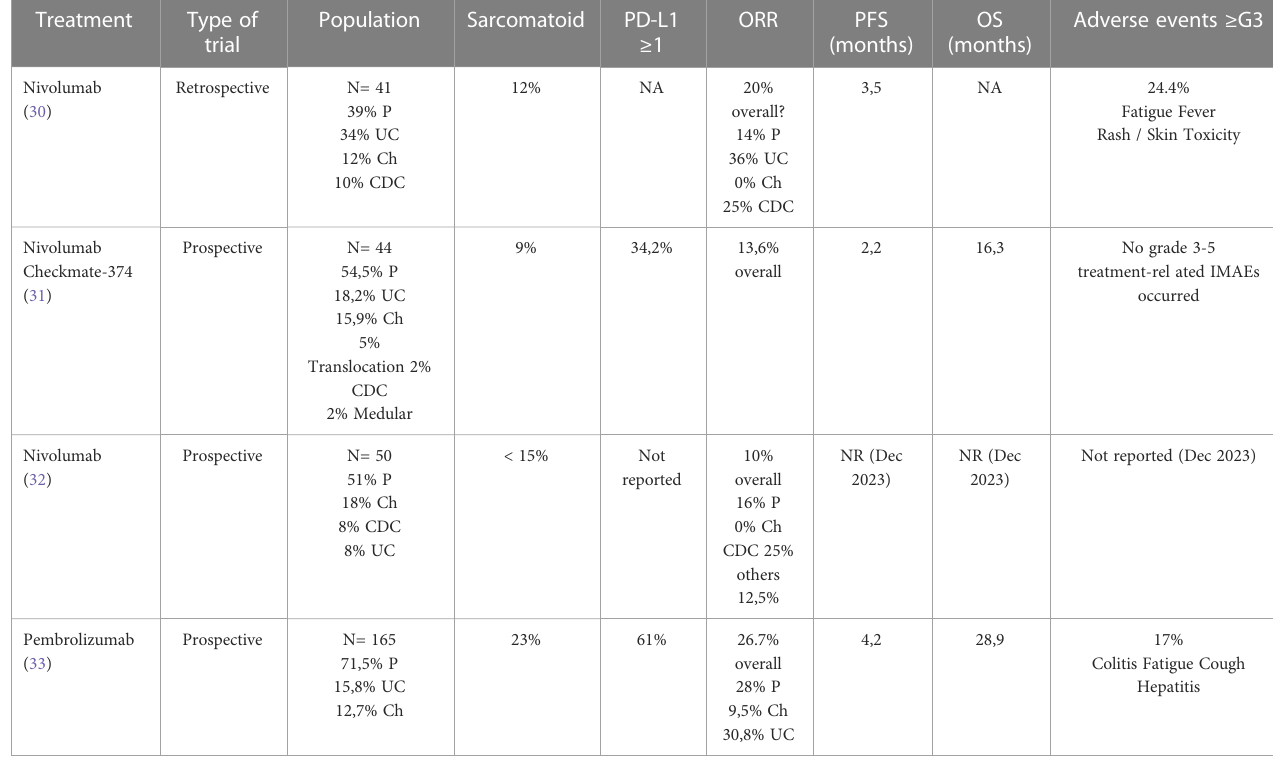
TABLE 1 Monotherapy inmune-checkpoint